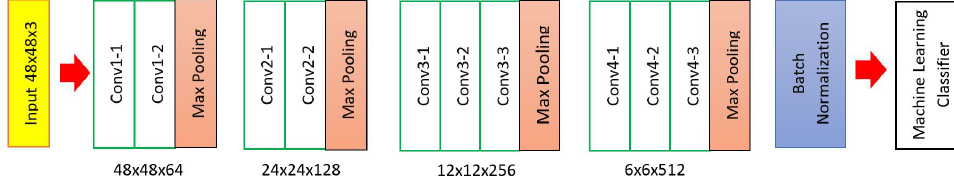
Figure 2. Architecture of the lightweight VGG16 feature extractor model.